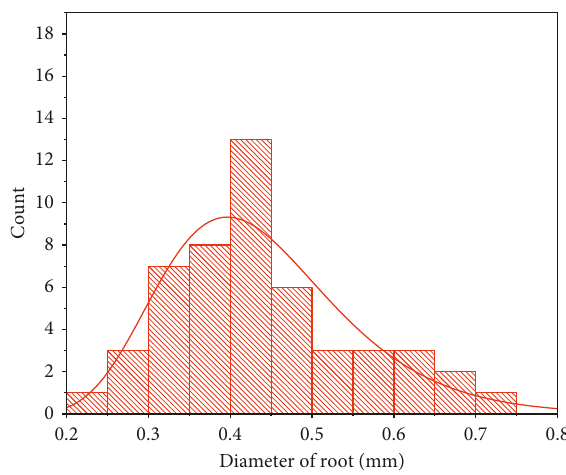
Figure 3: Distribution of the diameter of 50